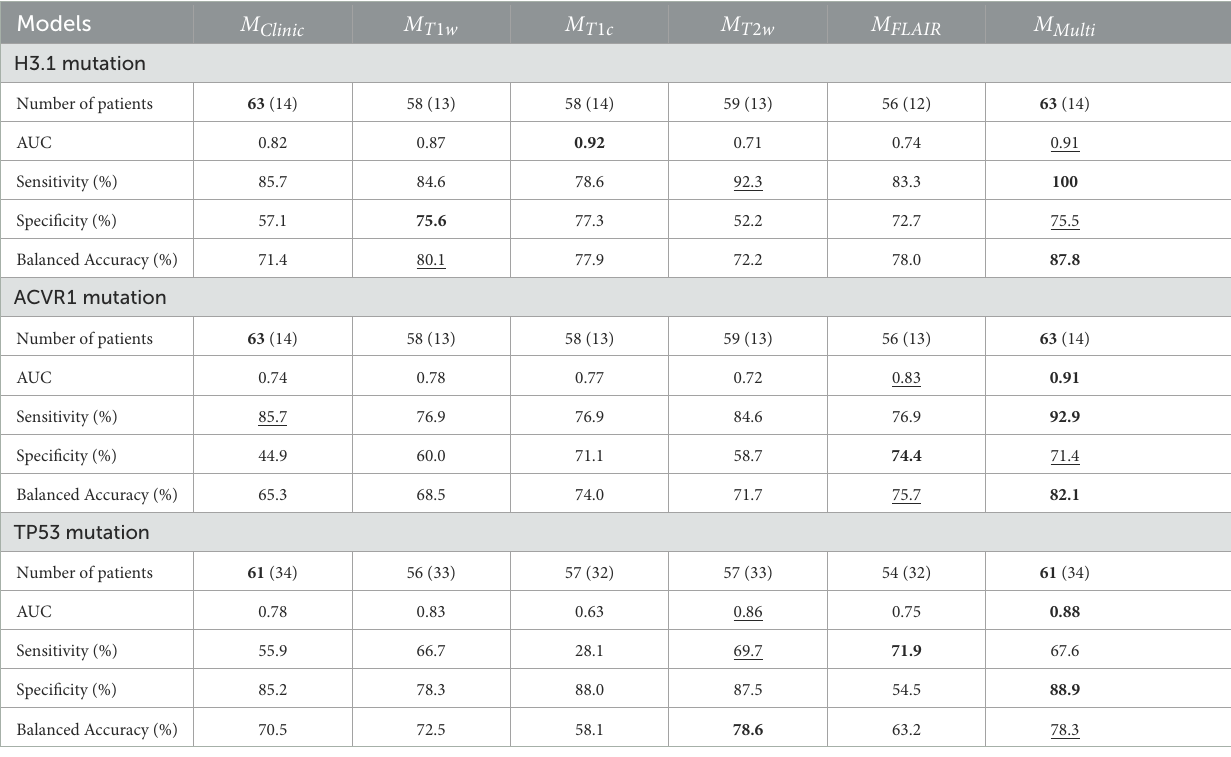
TABLE 6 Prediction results for the six models: M Clinic , M T 1 w , M T 1 c , M T 2 w , M FLAIR , and M Multi in a LOO-CV framework.